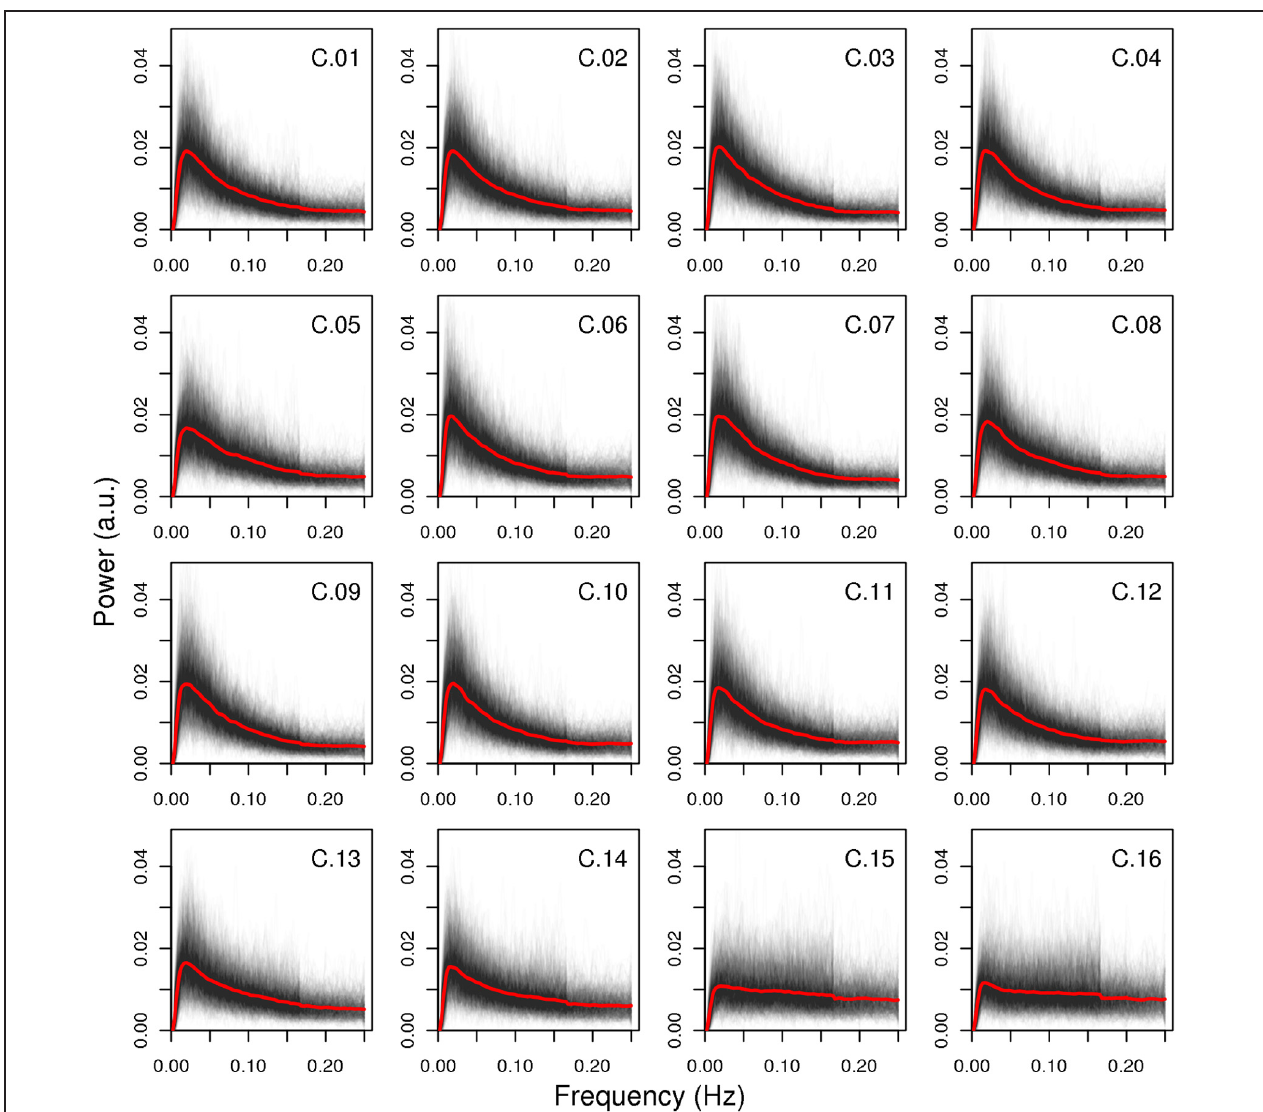
FIGURE 6 | Spectra of all components. All single-subject spectra were drawn as black lines, and the mean spectrum of each component is displayed as a red line. The artifact components C.15 and C.16 have markedly different